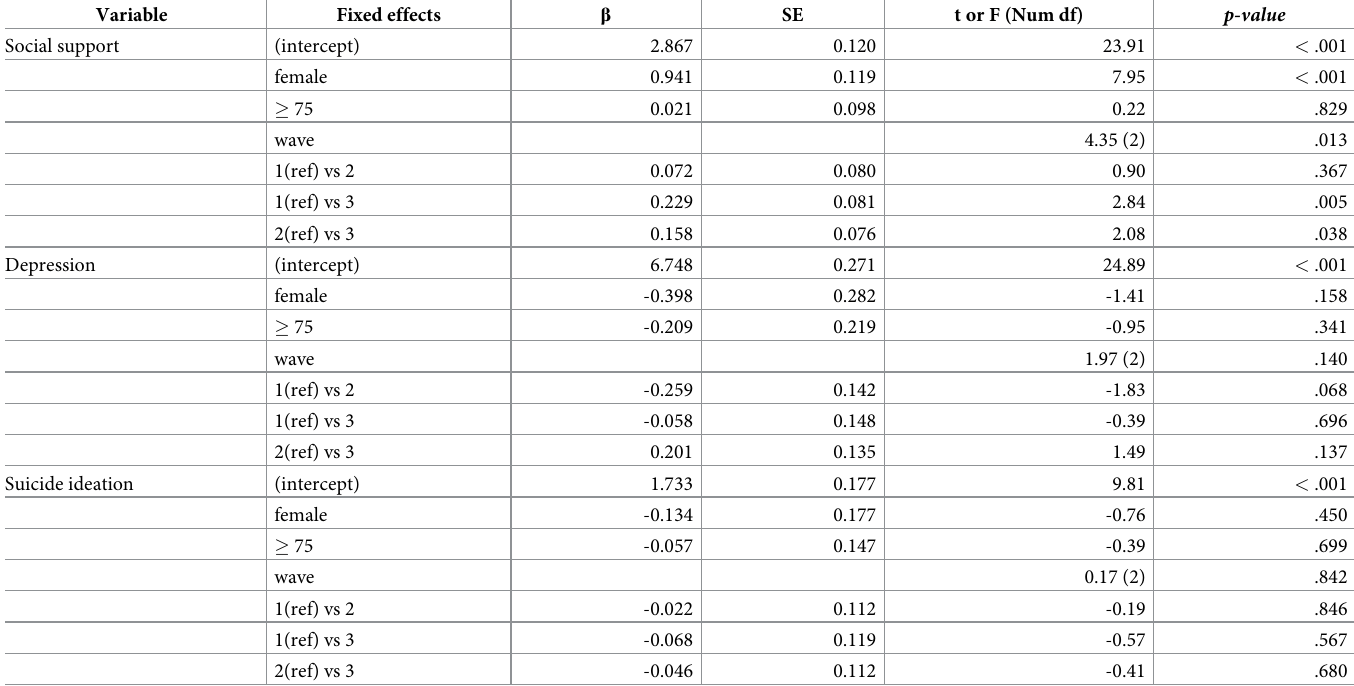
Table 3. Estimation of coefficients from generalized linear mixed modeling for continuous variables.